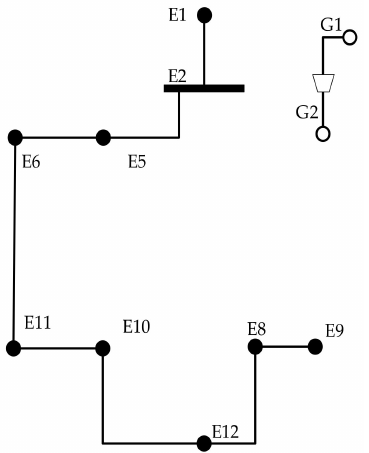
Figure 11. Diagram of the restoration topology in Case 1.